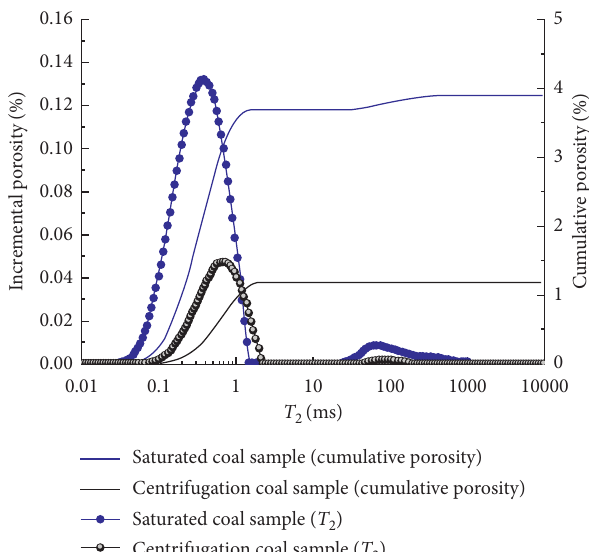
Figure 7: T 2 distribution and porosity distribution of parallel layers at saturated and centrifugal conditions.